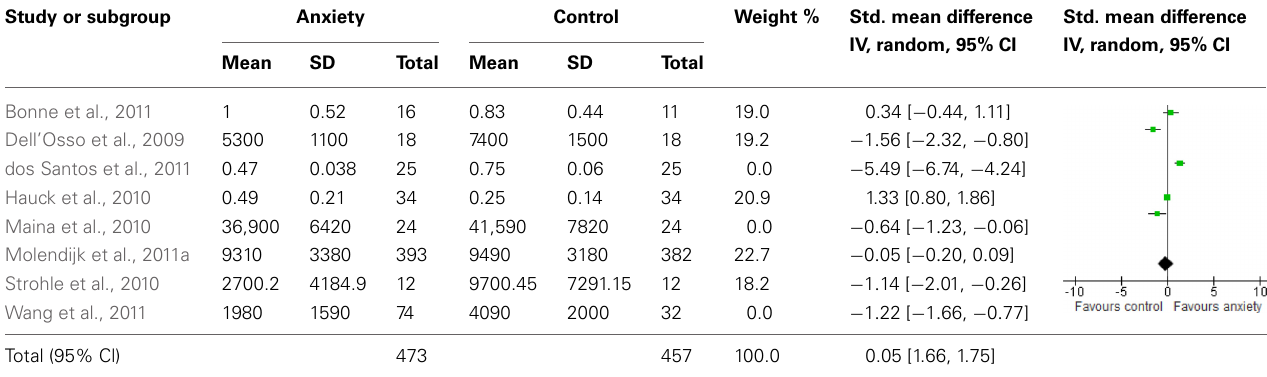
Table 8 | Meta-regression analysis with OCD studies excluded. Study or